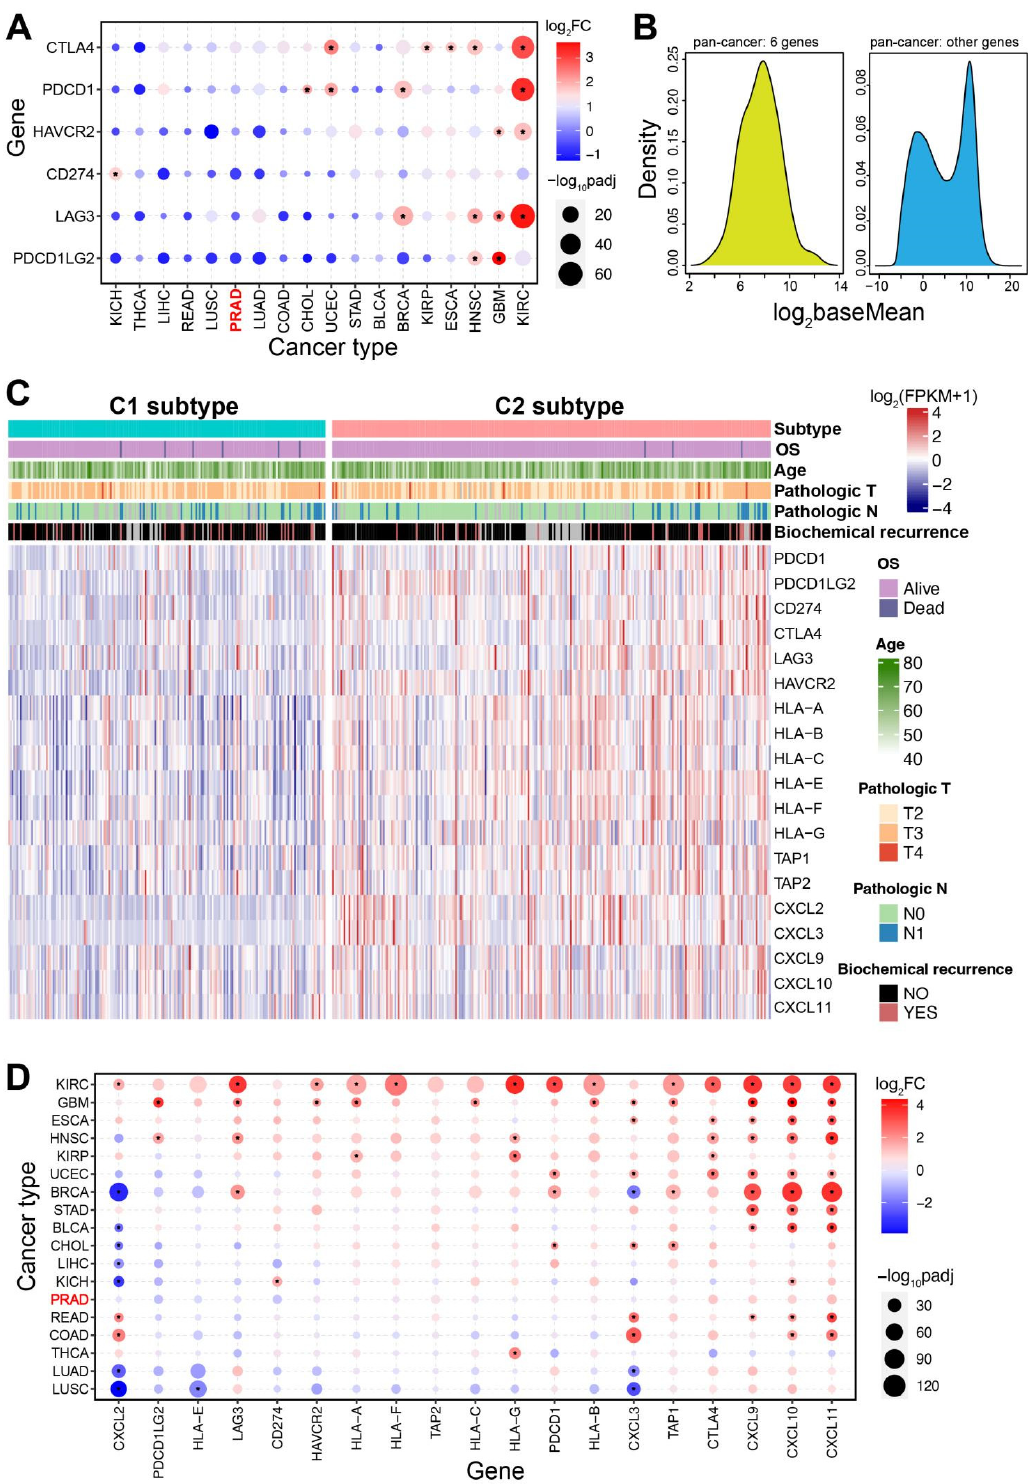
Figure 3. Pan-cancer expression analysis of the immune-related genes. ( A ). A pan-cancer expression analysis of immune checkpoint genes indicates diverse expression patterns across cancers. ( B ). The expression distributions of six immune checkpoint genes and other genes demonstrate the similar expression levels. The red word “PRAD” in Figure 3B is the main cancer type in this study. ( C ). A heatmap shows expression distributions of the 28 immune gene sets between the two subtypes. ( D ). A pan-cancer expression analysis of related immune genes in ( C ) shows diverse expression patterns across